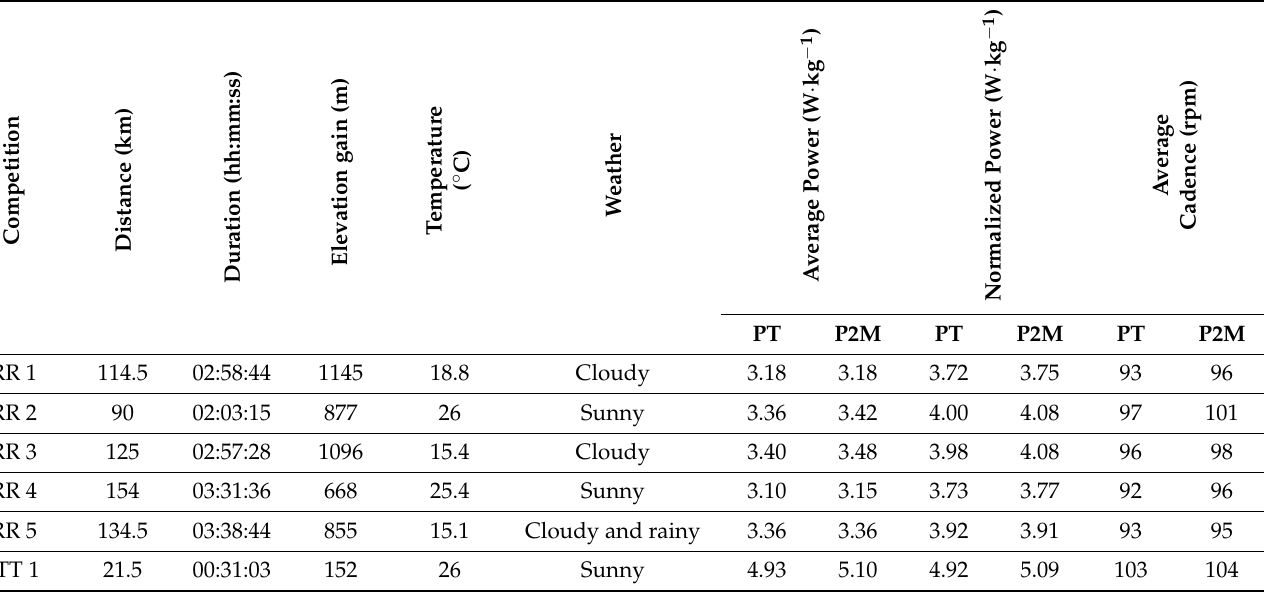
Table 1. Characteristics of the six official cycling competitions, average power output and cadence obtained by both the PowerTap and Power2Max power